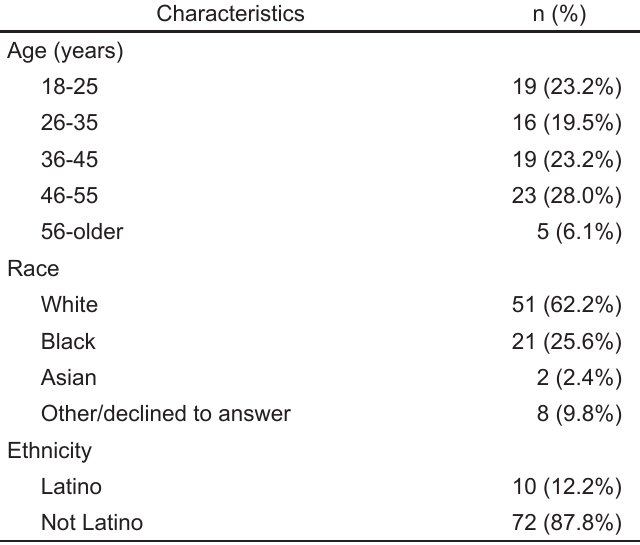
Table. Characteristics of included patients in tablet computer- based screening for possible risk for opioid